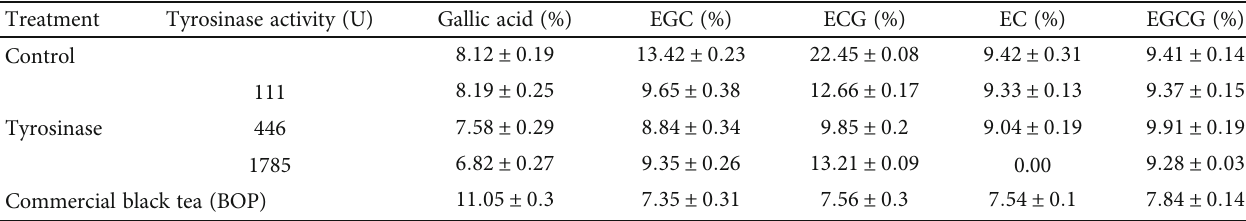
Values are expressed as mean ± standarddeviation of three replications.